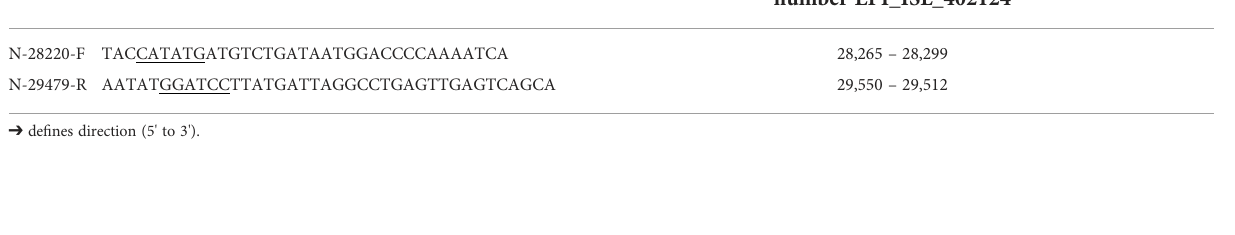
TABLE 1 Primer for cloning of the N-proteins ( NdeI and BamHI sites are underlined).